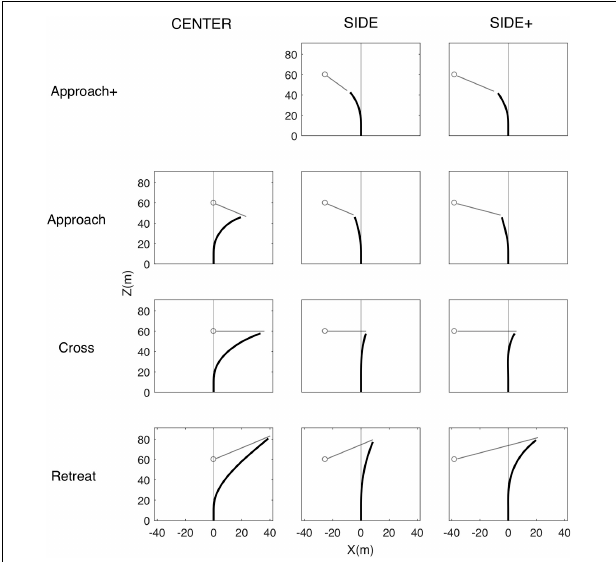
FIGURE 3 | Overall average locomotor paths (in black) under the CENTER, SIDE, and SIDE+ eccentricity conditions for the Approach+, Approach, Cross, and Retreat target directions. Note that the Approach+ target direction was absent under the CENTER eccentricity condition. Gray outline dots and attached line segments indicate initial target positions and subsequent target trajectories.